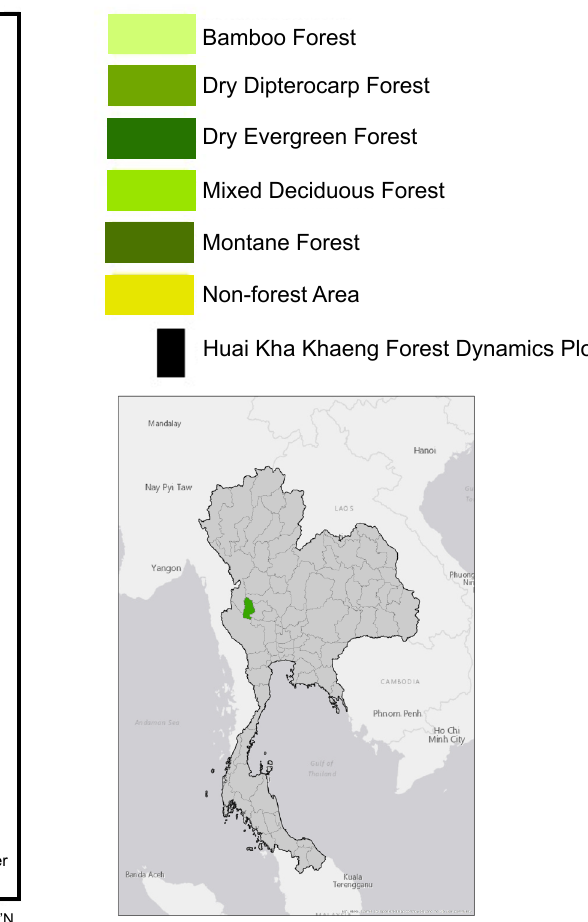
Figure 1. Location of the 50-hectare long-term forest dynamics plot in Huai Kha Khaeng Wildlife Sanctuary, Uthai Thani Province,